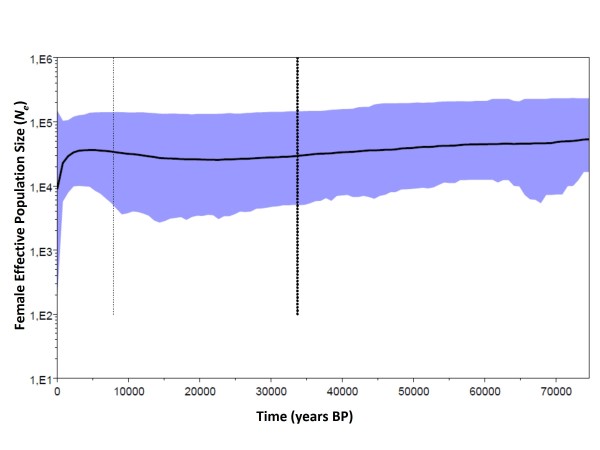
Bayesian Skyline plot of populations from areas covered by ice sheet during LGM (clade from SFC) showing the effective population size stability throughout time. X axis: time in years BP, Y axis: is Ne (female effective population size). The middle line is the median estimate, and the grey area shows the 95% highest probability density (HPD).